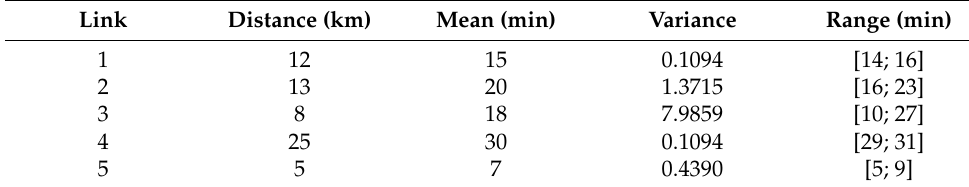
Figure 3. Network used in the experiment. Table 1. Distribution of link travel